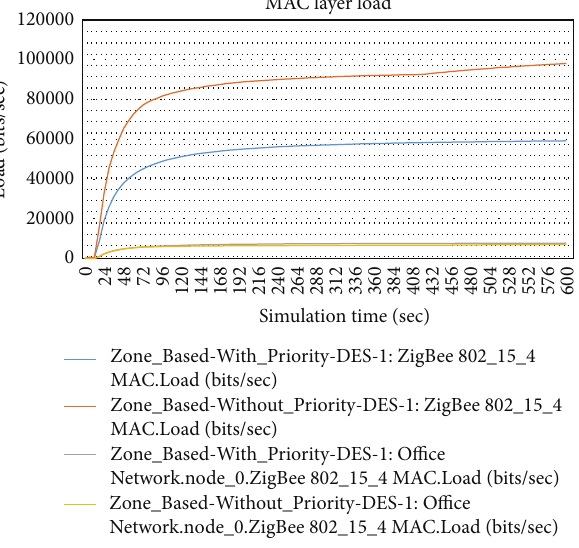
Figure 4: MAC load (bits/sec) for global model and Coordinator (node 0).